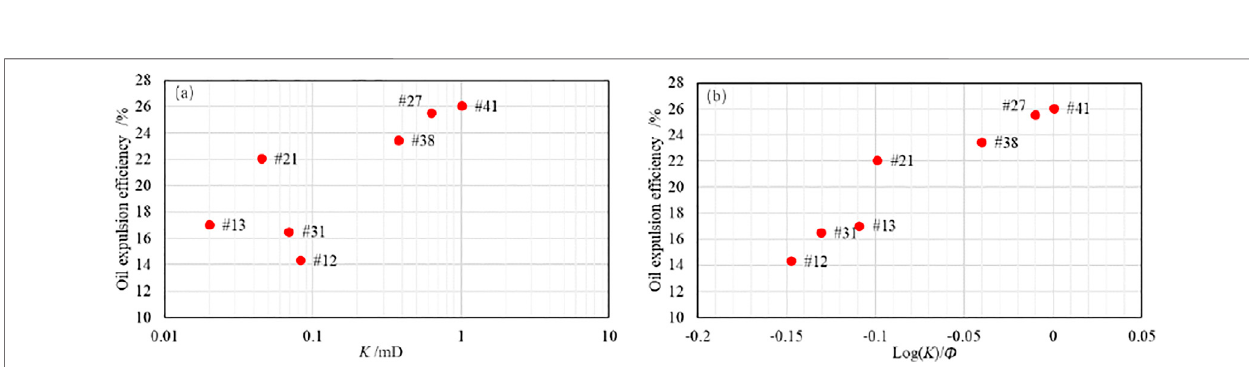
FIGURE 9 | Relationship between reservoir physical properties and oil-expulsion ef fi ciency at differential pressure of 35 MPa.